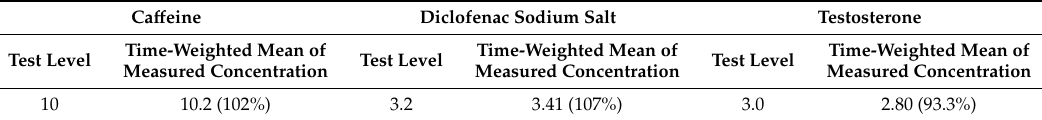
Table 1. Measured concentrations of test compounds in test solutions (C w s) used to determine concentrations in zebrafish embryos or larvae (C e s).